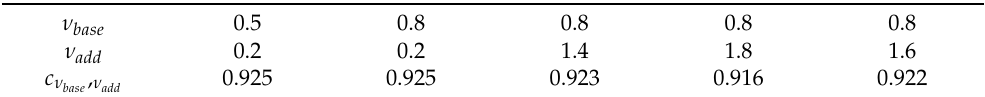
Table 2. Correlation coefficients c ν , ν between the spectral line dynamics at the basic frequency base add ν base and the linear combinations of the basic frequencies ν add .